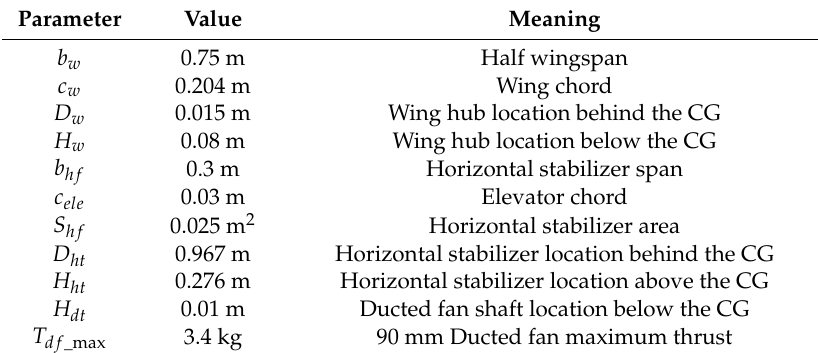
Table 3. Compound component